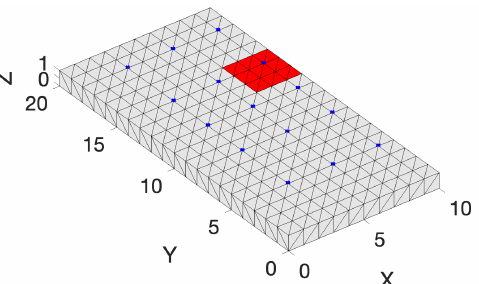
Figure 2. Damaged region (red) and location of the 30 sensors (nodes highlighted in blue).